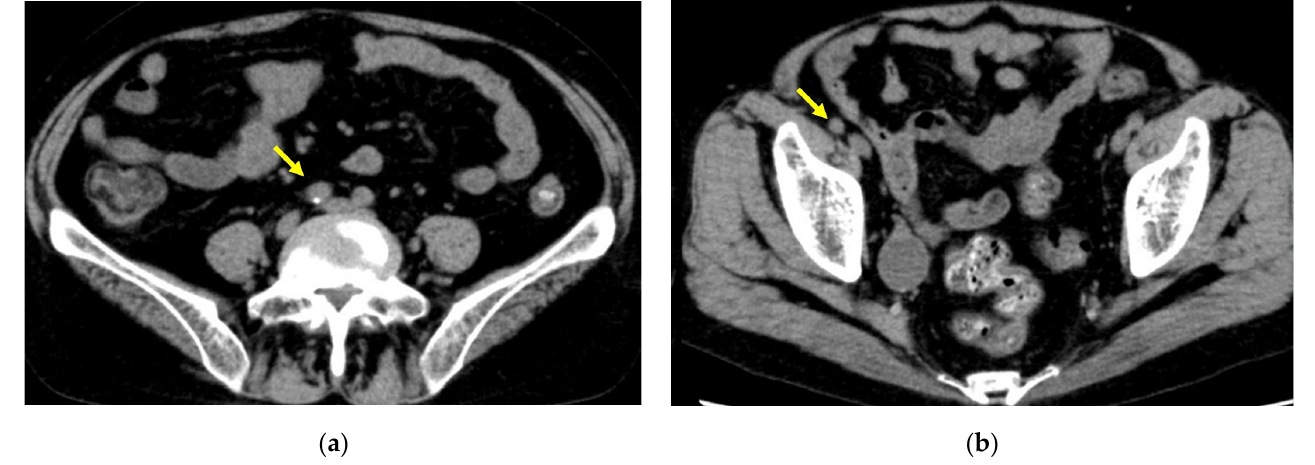
Figure 1. Preoperative computed tomography images of the ( a ) common iliac artery and the ( b ) external iliac artery, showing minimal calcification of the arteries (yellow arrows).